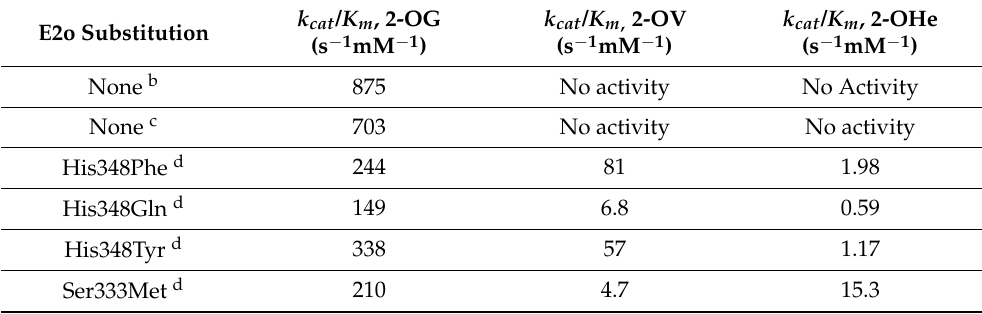
Table 3. Catalytic efficiency of the OGDH complexes assembled with E2o variants a [110]. k cat /K m , 2-OG E2o Substitution (s − 1 mM − 1